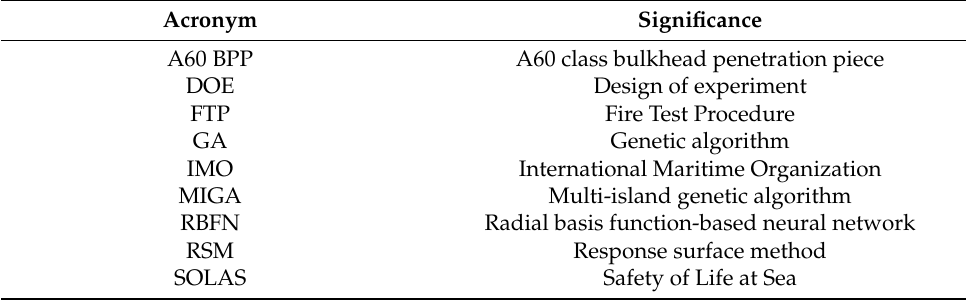
Table A1. List of acronyms.